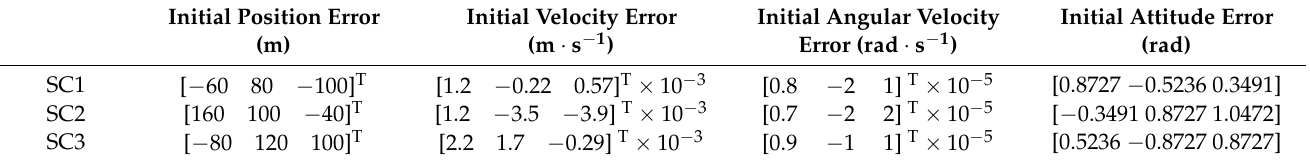
Table 2. Initial conditions.